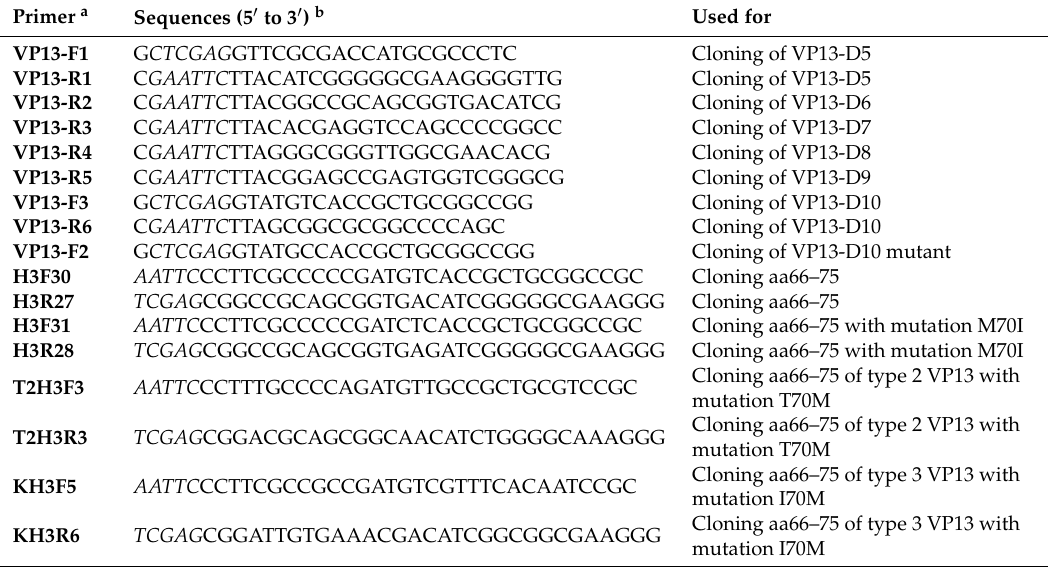
Table 1. List of primers used in this